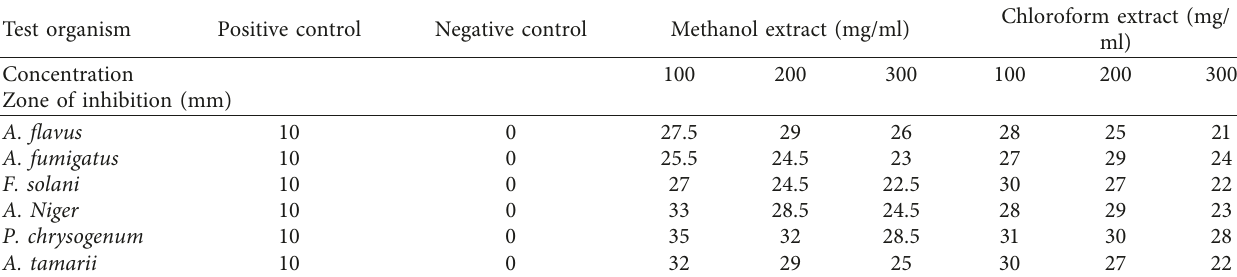
Table 3: Antifungal activity of the methanol extract and chloroform fraction of N.